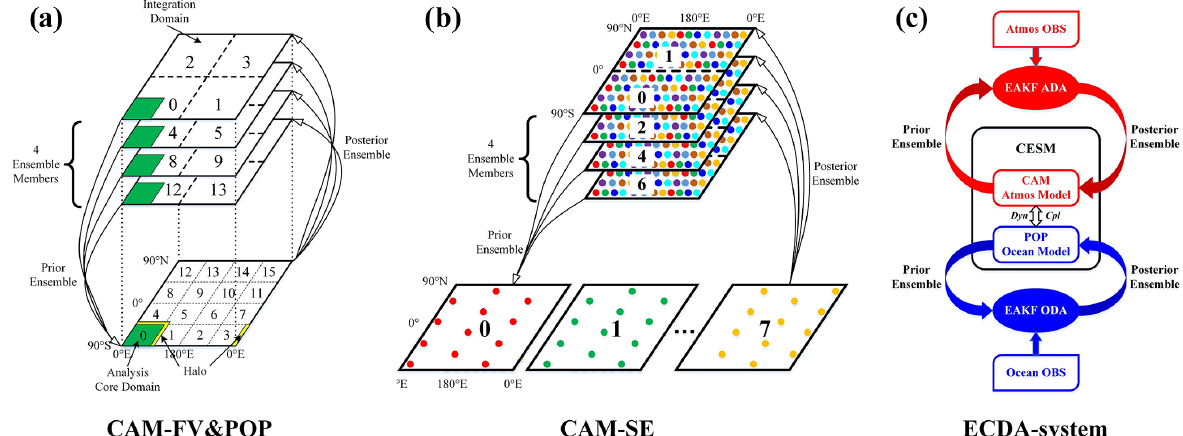
Figure 1. (a) The parallel domain decomposition and the online ensemble collection and distribution of a scalar field with CAM-FV. The four ensemble members are integrated forward in time in parallel, using four processors for each member. At analysis time, the ensemble members are synchronized, and the global four-element ensemble vectors are decomposed onto all 16 analysis processors. For each physical field, each analysis processor sequentially uses the observations to update the ensemble vectors at each grid point in its core domain (green) and halo (yellow). Once all nearby observations have been assimilated, the updated ensemble vectors in the core domains are transmitted back to the integration processors, completing the cycle. (b) The parallel domain decomposition and the online ensemble collection and distribution of a scalar field with CAM-SE. Different from CAM-FV, CAM-SE uses the cubed-sphere grid. To address this grid change, the implementation of domain decomposition with CAM-SE adopts a similar fashion to that used in DART (Anderson et al., 2009). This new method allows us to “randomly” assign model states to different PEs. And the calculation of the forward operator is realized based on the MPI2 remote memory access (RMA). At analysis time, the ensemble members are synchronized, and the global ensemble vectors are randomly decomposed onto all eight PEs (grid points with same color in the figure). (c) Schematic of the CESM-ECDA system. During the forecast stage of a DA cycle, ensembles of various components, including CAM and POP, of the CESM system are integrated forward. The atmosphere model and ocean model are dynamically coupled together during the forecast phase (the double arrow between CAM and POP). Taking the atmosphere component as an example, when the analysis time of the atmosphere is reached, the CESM ensemble integration is suspended and the forecast ensemble of CAM is used as the background for the assimilation of the atmospheric observations (the red upward- pointing curved arrow) using the EAKF algorithm (the red solid ellipse). When all the atmospheric observations have been assimilated, the analysis ensemble of CAM is used as the initial conditions of the forecast stage in the next DA cycle (the red downward-pointing curved arrow). The ODA cycle for the POP model is similar and marked as blue in the figure. The ADA and ODA may have the same or different